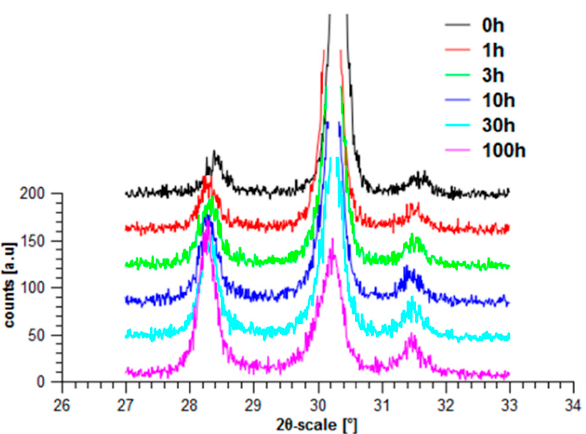
Figure 22. Hydrothermal treatment of ZY (Y-TZP based on coating technology).